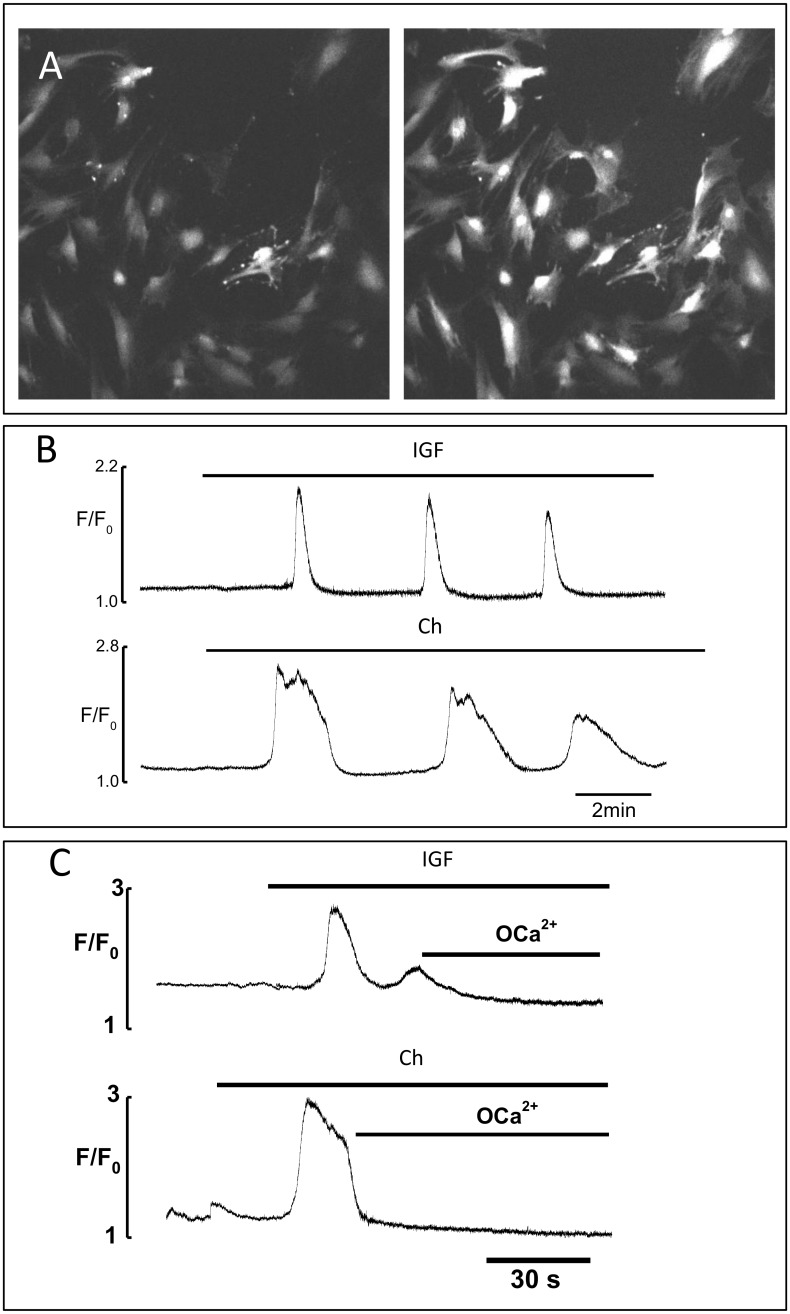
Effects of IGF and chemerin on Ca2+ signalling in MSCs.
A. Images of Fluo-4 loaded MSCs taken in the absence (left) and the presence (right) of chemerin (100nM), respectively. B. IGF-II (100 ng.ml-1, top) and chemerin (100nM, Ch) induce Ca2+ oscillations in Fluo-4 loaded cells. C. Relaxation of Ca2+ transients induced by chemerin or IGF-II after removal of external Ca2+ (Ca2+ free solution with 2mM EGTA).